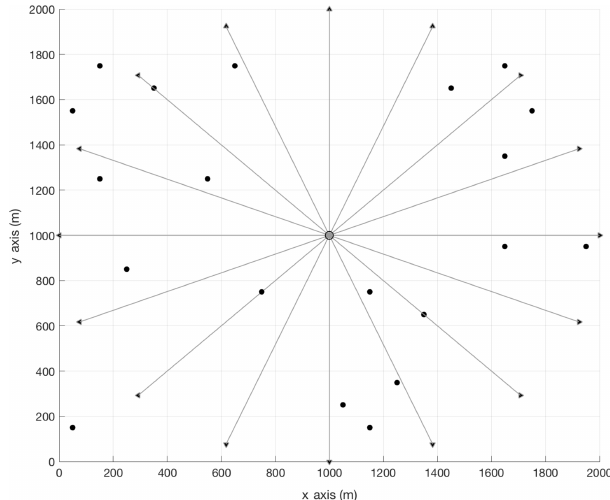
Figure 2. Map view of synthetic tests, with 20 source locations shown as black dots and 16 beams shown as gray lines that ex- tend from the spectrometer (circle at x = 1000m and y = 1000m) to retroreflectors (black